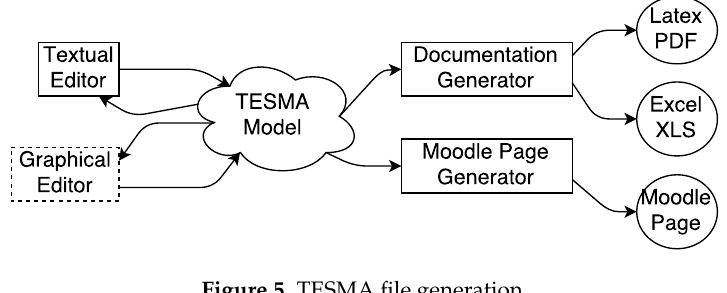
Figure 5. TESMA file